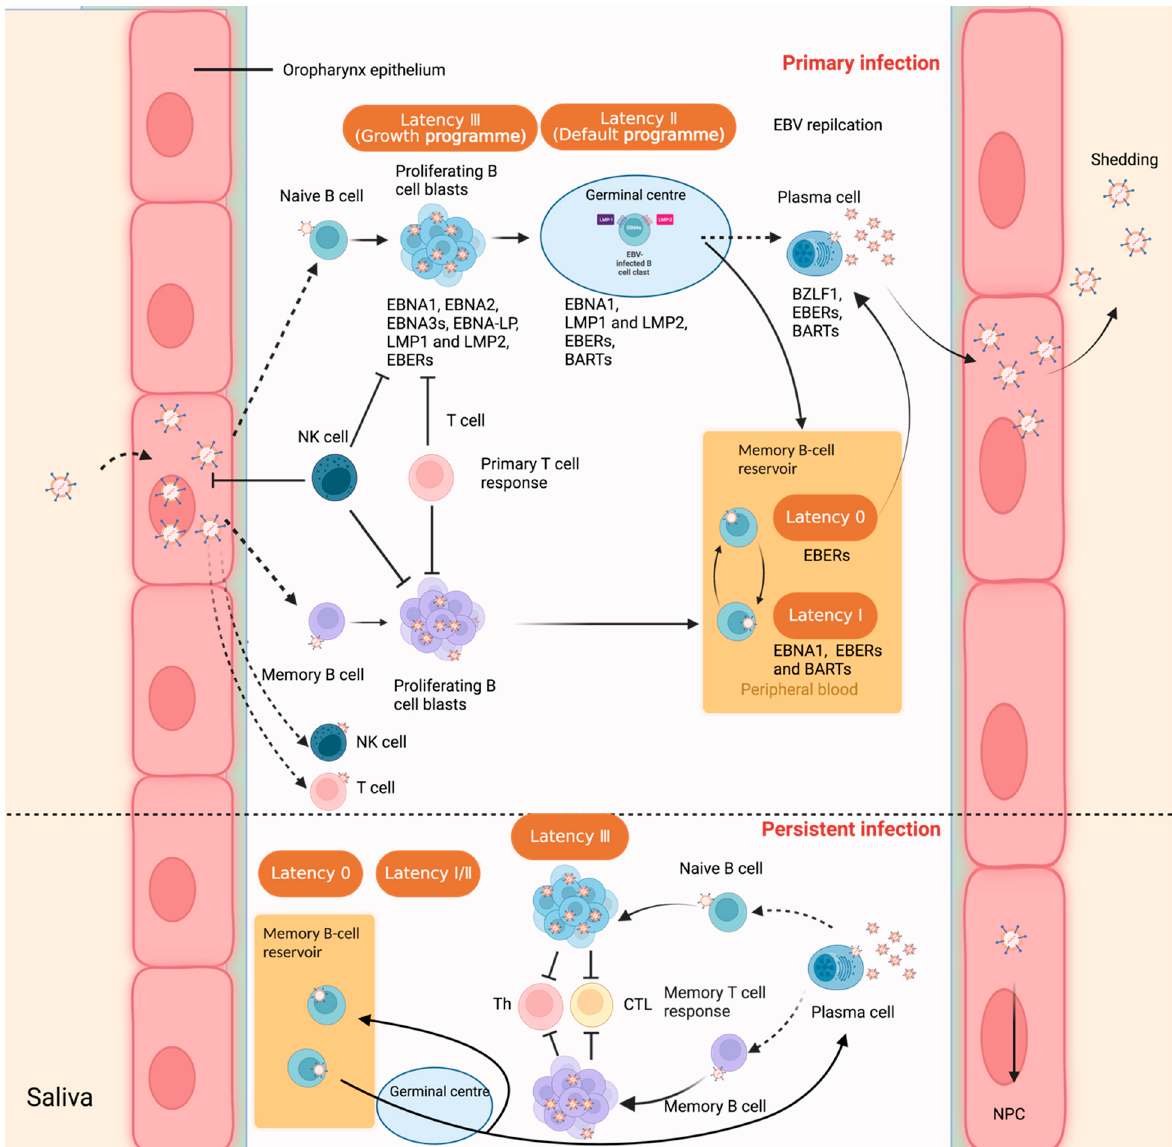
Figure 1. Interaction between Epstein–Barr virus and the human host, and virus latent infection in B lymphocytes. Upper panel: Primary infection. Epstein–Barr virus transmitted via saliva establishes